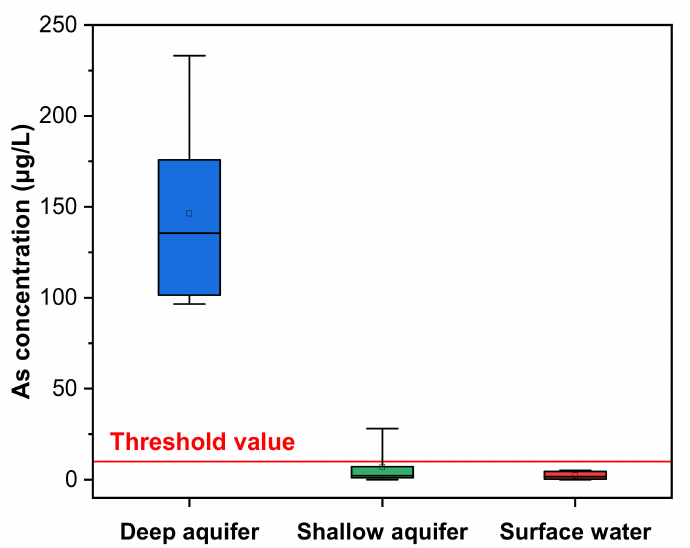
Figure 8. Box and whisker plot of As concentration values in the deep aquifer (in blue), the shallow aquifer (in green) and surface water (in red). Boxes indicate the 25th–75th percentile range, whiskers indicate the minimum–maximum range, squares indicate the mean value and horizontal lines the median. The red horizontal line indicates the threshold value for drinking water suggested by